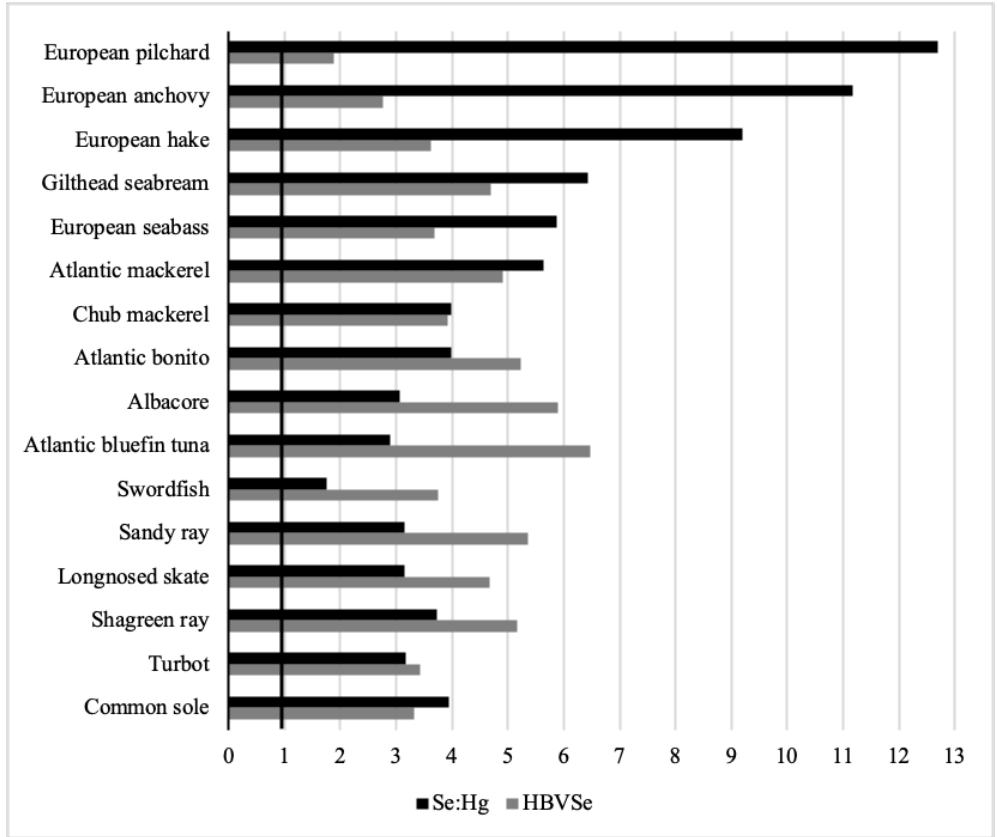
Figure 2. Se:Hg molar ratios and Se health benefit values (HBV Se ) of the studied fish species. Dark line: Se:Hg molar ratio > 1.